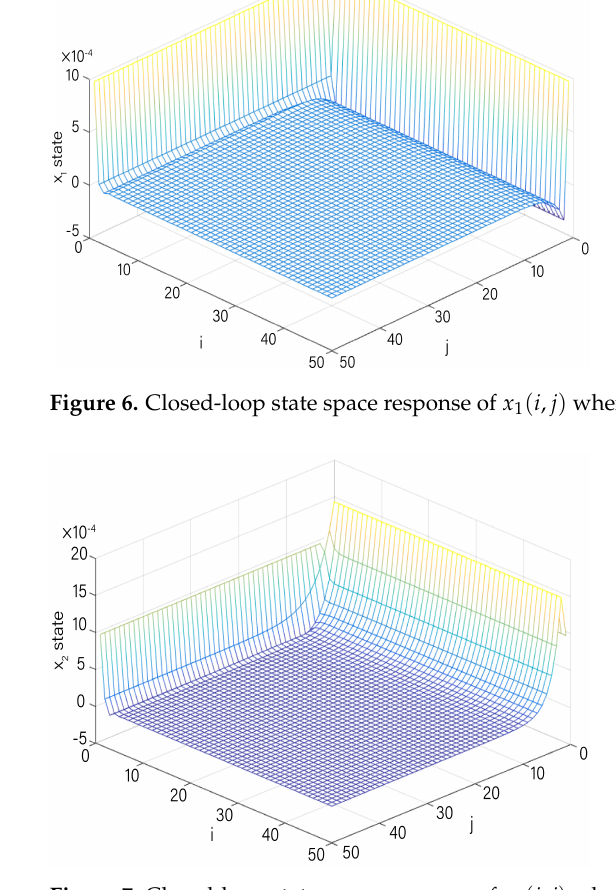
Figure 7. Closed-loop state space response of x 2 ( i , j ) when K = [0